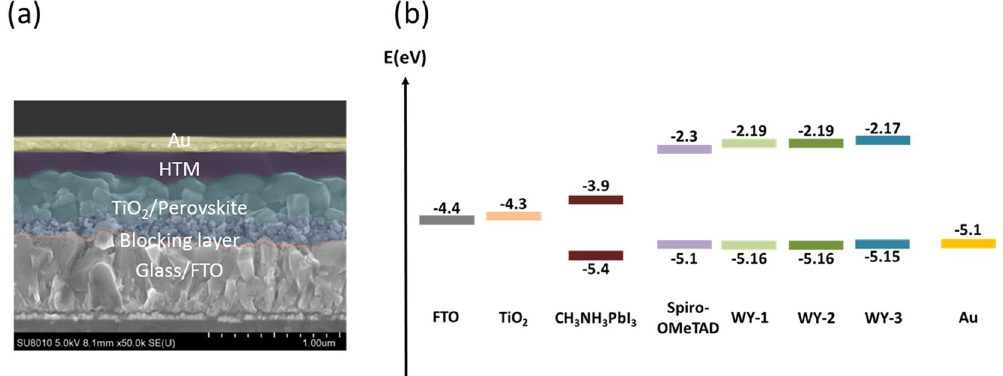
Figure 4. ( a ) Cross-section view of representative PSC and ( b ) energy level diagram of the materials used in the studied PSCs